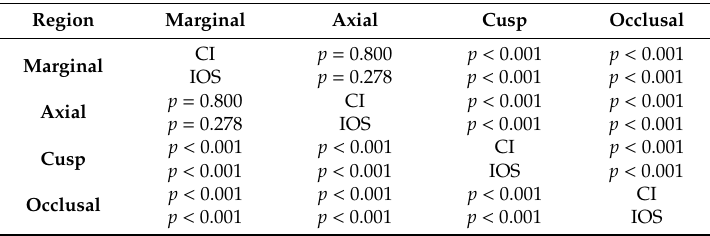
Table 3. Significances between regions of the replica.